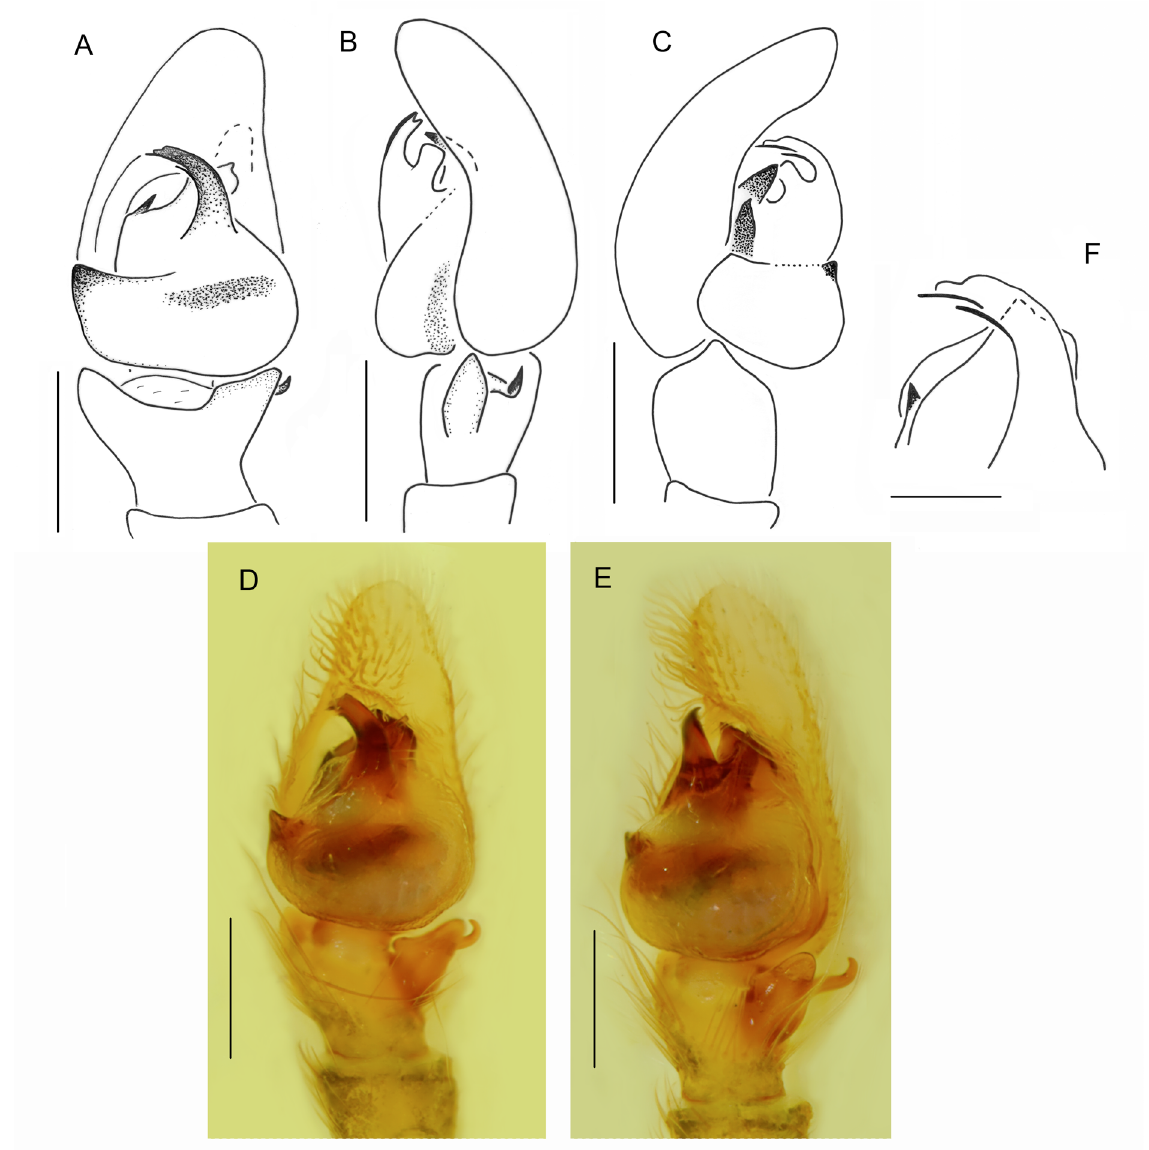
Fig. 5. Pochytoides obstipa sp. nov., paratypes, ♂. A–E . Palpal organ, A , D . Ventral view. B . Retrolateral view. C . Ventroprolateral view. E . Ventroretrolateral view F . embolic division. scale bars: A–e = 0.3 mm, F = 0.1